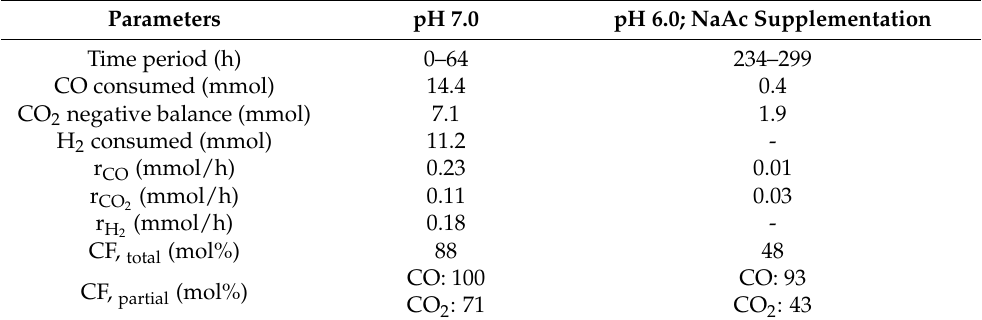
Table 5. CO, CO 2 and H 2 consumption and carbon fixation during the bioconversion of Syngas B by B. methylotrophicum